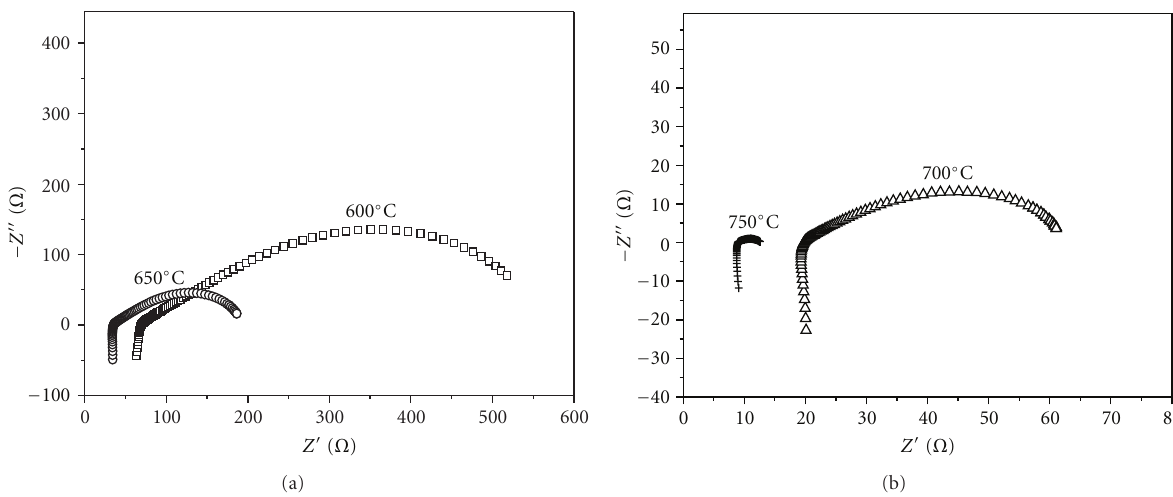
Figure 4: Nyquist representations for the (1 − x )CeO 2 · x /2Bi 2 O 3 sample with x = 0 . 7 at various temperatures. This composite sample presents an optimal